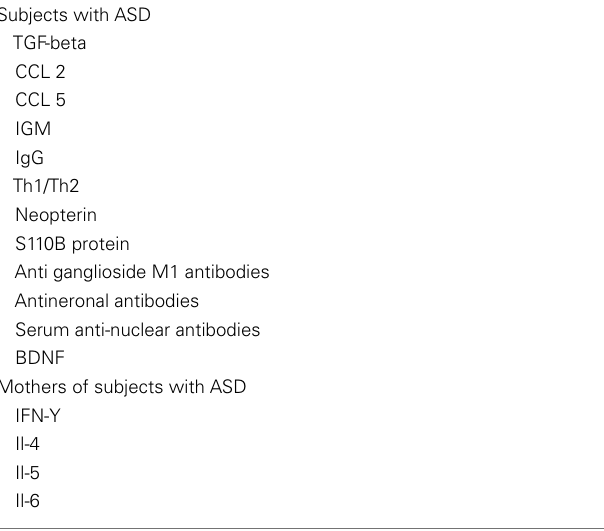
Table 5 | Immune biomarkers inASD (see text for references)